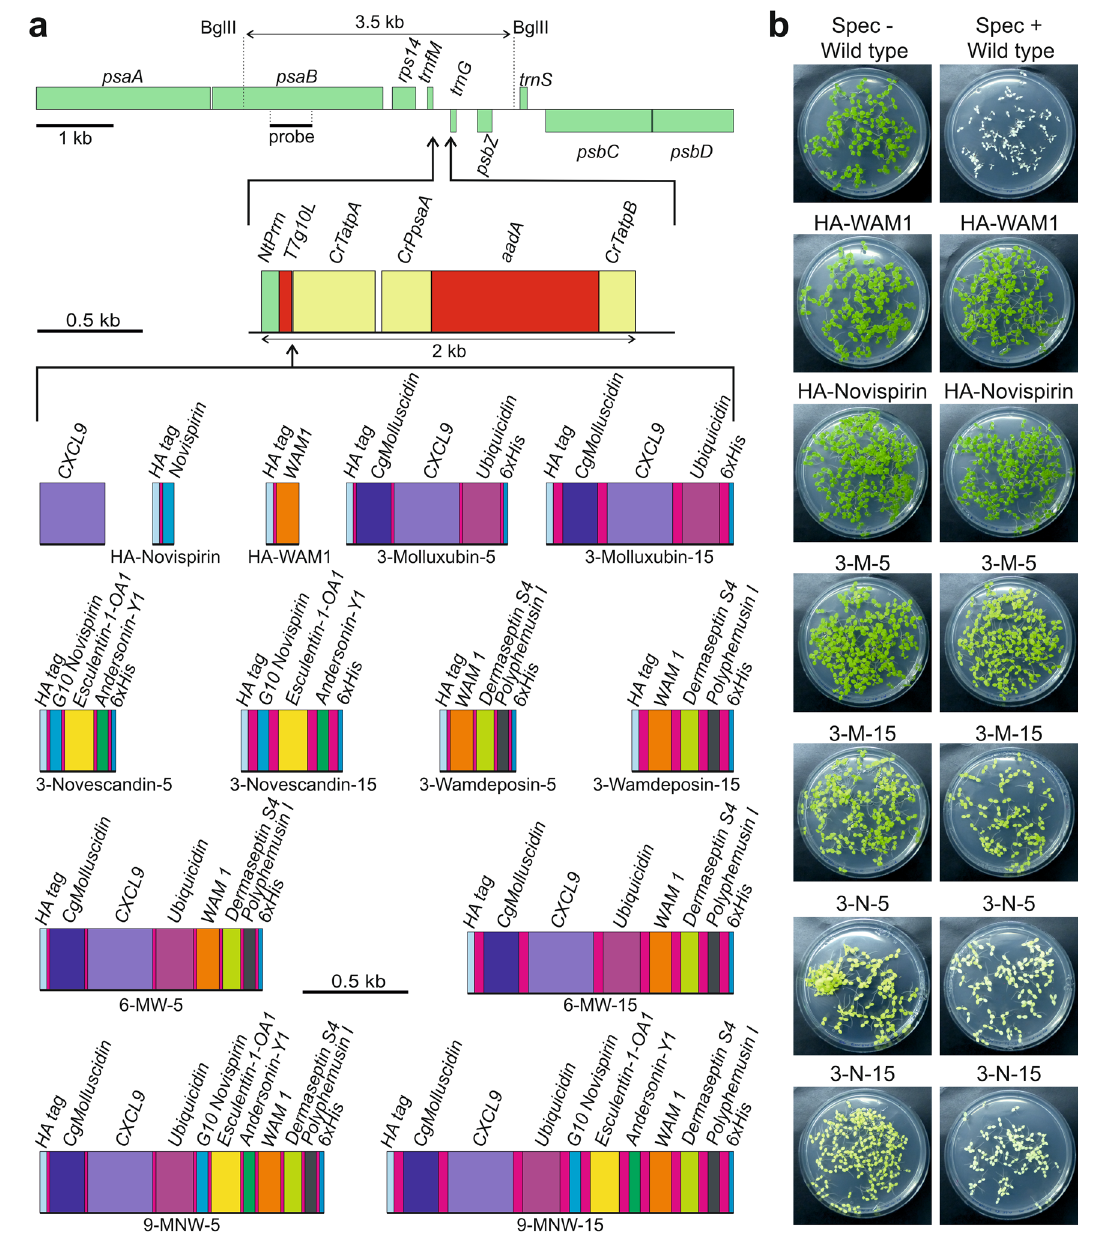
Fig. 1 | Constitutive AMP and fAMP expression from the tobacco plastid gen- ome. a Sequences encoding AMPs or fAMPs were placed under the control of the Nicotianatabacum plastidribosomalRNAoperonpromoter( NtPrrn ),theT7phage gene10 leader ( T7g10L ) as 5 ′ UTR and the 3 ′ UTR of the atpA gene from Chlamy- domonas reinhardtii ( CrTatpA ). The spectinomycin resistance gene aadA for selectionoftransplastomiclineswasdrivenbythe ChlamydomonaspsaA promoter and 5 ′ UTR (CrPpsaA) , and the 3 ′ UTR of the Chlamydomonas atpB gene ( CrTatpB ). Different combinations of AMPs were linked with linkers of 5 or 15 amino acids (pink). The constructs were fl anked by homology regions for integration into the